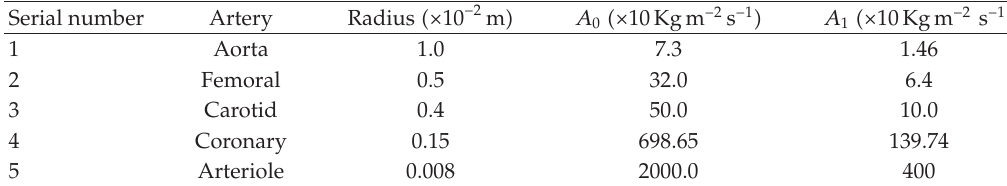
Table 2: Physiological data for di ff erent arteries.